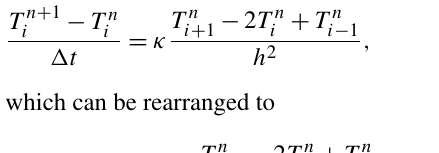
Figure A1. 1-D discretisation in space (horizontal axis) and time (vertical